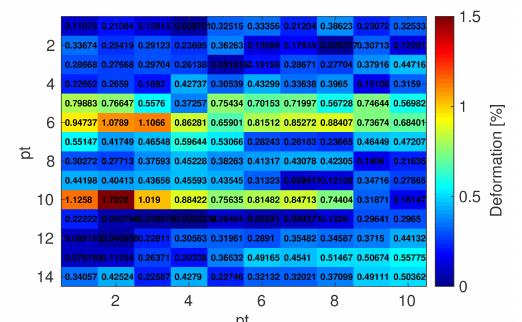
Figure 6. Full-field strain map of the sample 22 (smaller pellets).